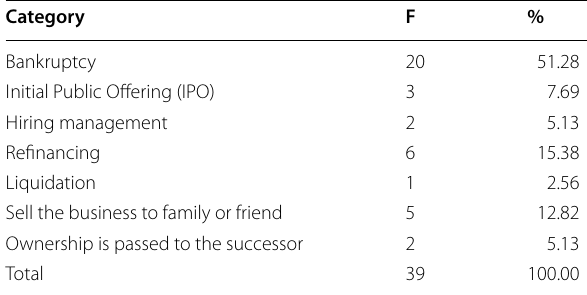
Sources: Table compiled by the